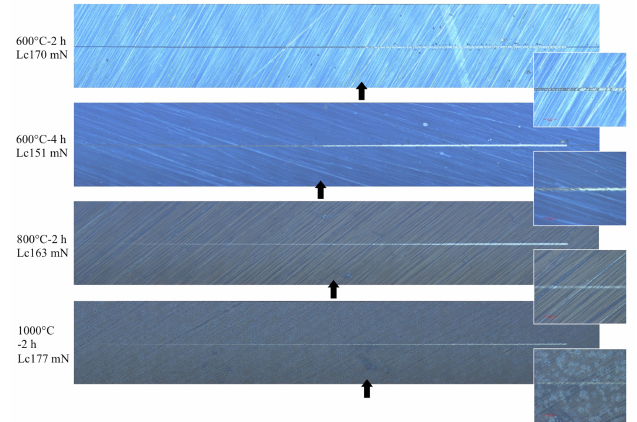
Figure 5. Panoramic images of the scratch trace and the images at the first crack in the coating of representative samples. Arrows: The first crack in the coating.